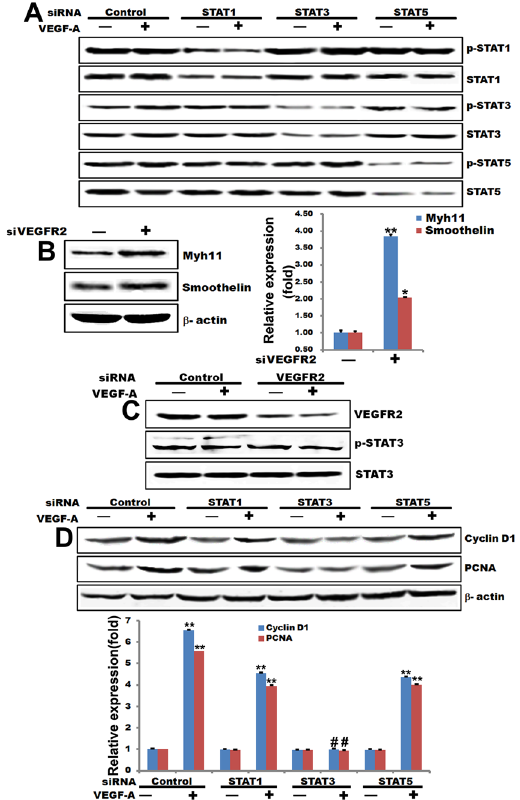
Figure 1. STAT3 acts as a downstream mediator for VEGFR2 activation induced by VEGF-A. ( A ) Western blot analysis of T/G HA-VSMC cells transfected with siRNAs for STAT1, STAT3, or STAT5 and treated with 100 ng/ mL VEGF-A for 48 hours. ( B ) Western blot analysis of T/G HA-VSMC cells transfected with siRNAs for Myh11 and Smoothlin and quantified the western blot data by Quantity One software. β -actin is a loading control. ** p < 0.01, * p < 0.05. n = 3. ( C ) Western blot analysis of transfected with a mixture of VEGFR2 siRNA and treated with100 ng/mL VEGF-A for 48 hours ( D ) Western blot analysis of Cyclin D1 and PCNA protein level in T/G HA-VSMC cells with siRNAs for STAT1, STAT3, or STAT5 and treated with 100 ng/mL VEGF-A for 48 hours and quantified the western blot data by Quantity One software. β -actin is a loading control. ** p < 0.01, * p < 0.05, # p > 0.05. n =